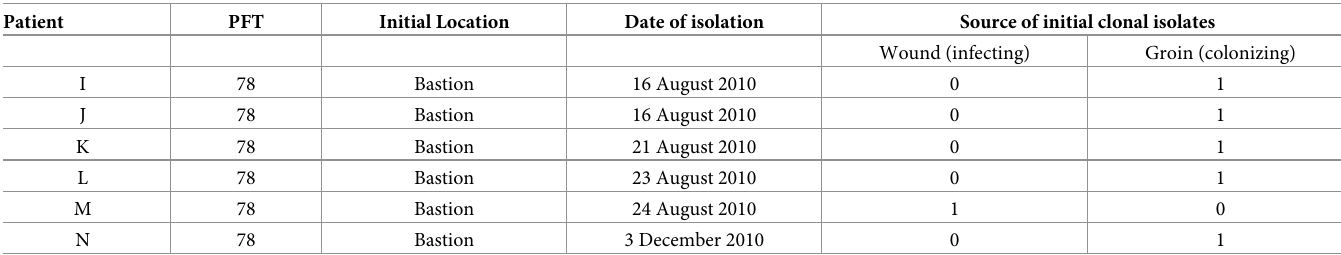
Table 3. Outbreak analysis of the single pulsed-field gel electrophoresis type (PFT) 78.